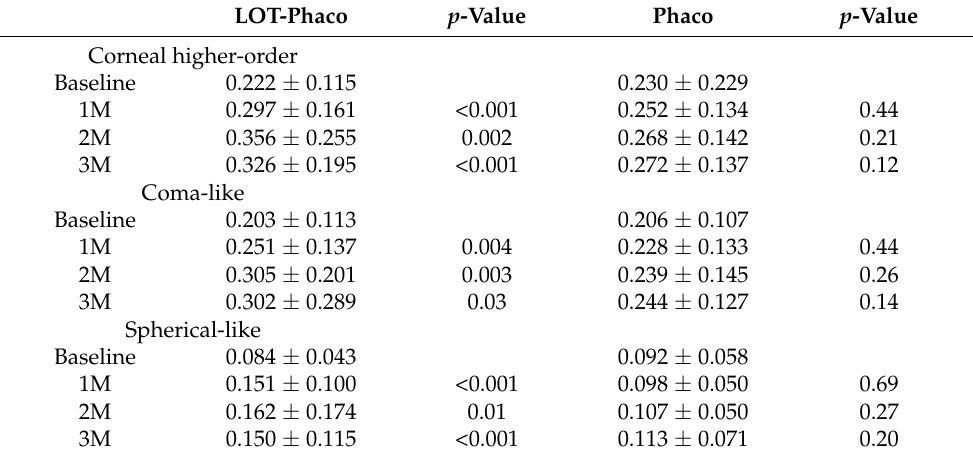
Table 3. Postoperative corneal higher-order, coma-like, and spherical-like aberrations.